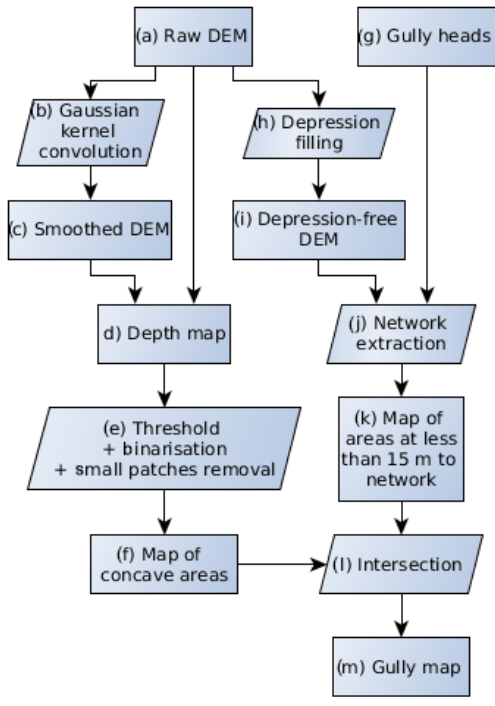
Figure 3. Flow chart of the method used to map gullies from the kite DEM. The letters associated with each step are referenced in the text describing the method in Sect.